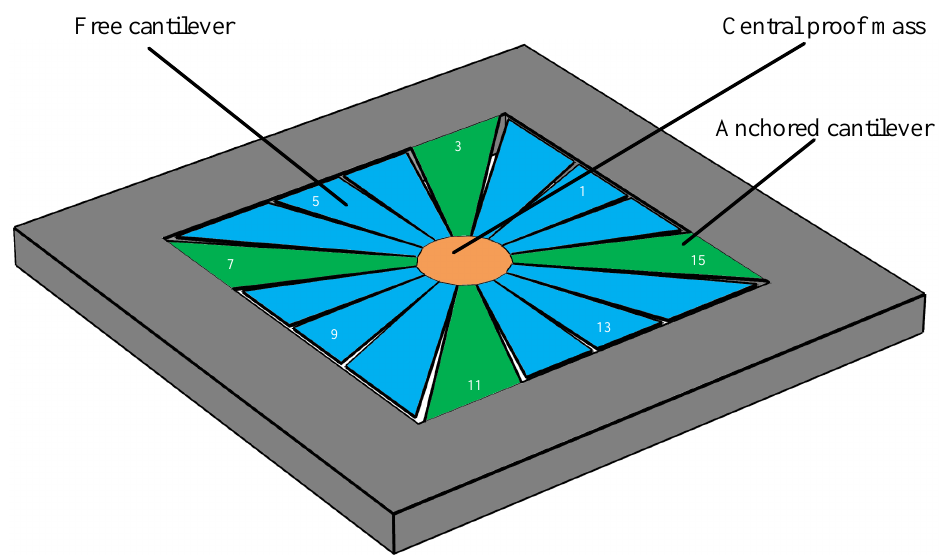
Figure 2. Illustration of one of the available anchoring schemes of the squared daisy MEMS resonator. In this anchoring scheme, the cantilevers 3, 7, 11, and 15 are anchored and shown in green, while the others are free and shown in